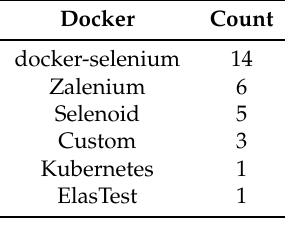
Table A12. 4.c. If you use Docker with Selenium, which tool do you use to manage the containers?